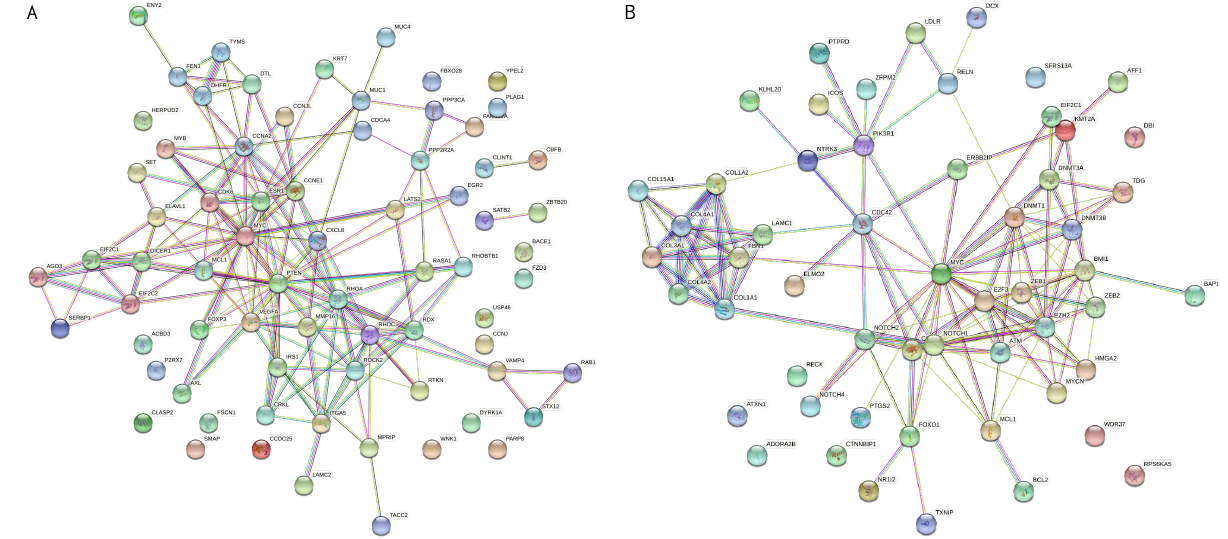
Figure 2. STRING protein-protein interaction (PPI) network. ( A ) PPI network for the upregulated DE-miRNAs predicted 75 genes (73 nodes and 188 edges, PPI enrichment p < 1.0 × 10 − 16 ; ( B ) PPI for the upregulated DE-miRNAs predicted 57 genes (56 nodes and 186 edges, PPI enrichment p < 1.0 × 10 − 16 ); the color nodes represent proteins. The edges represent